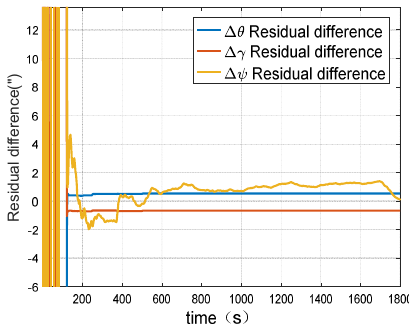
Figure 9. Dynamic simulation result of misalignment angles between systems.